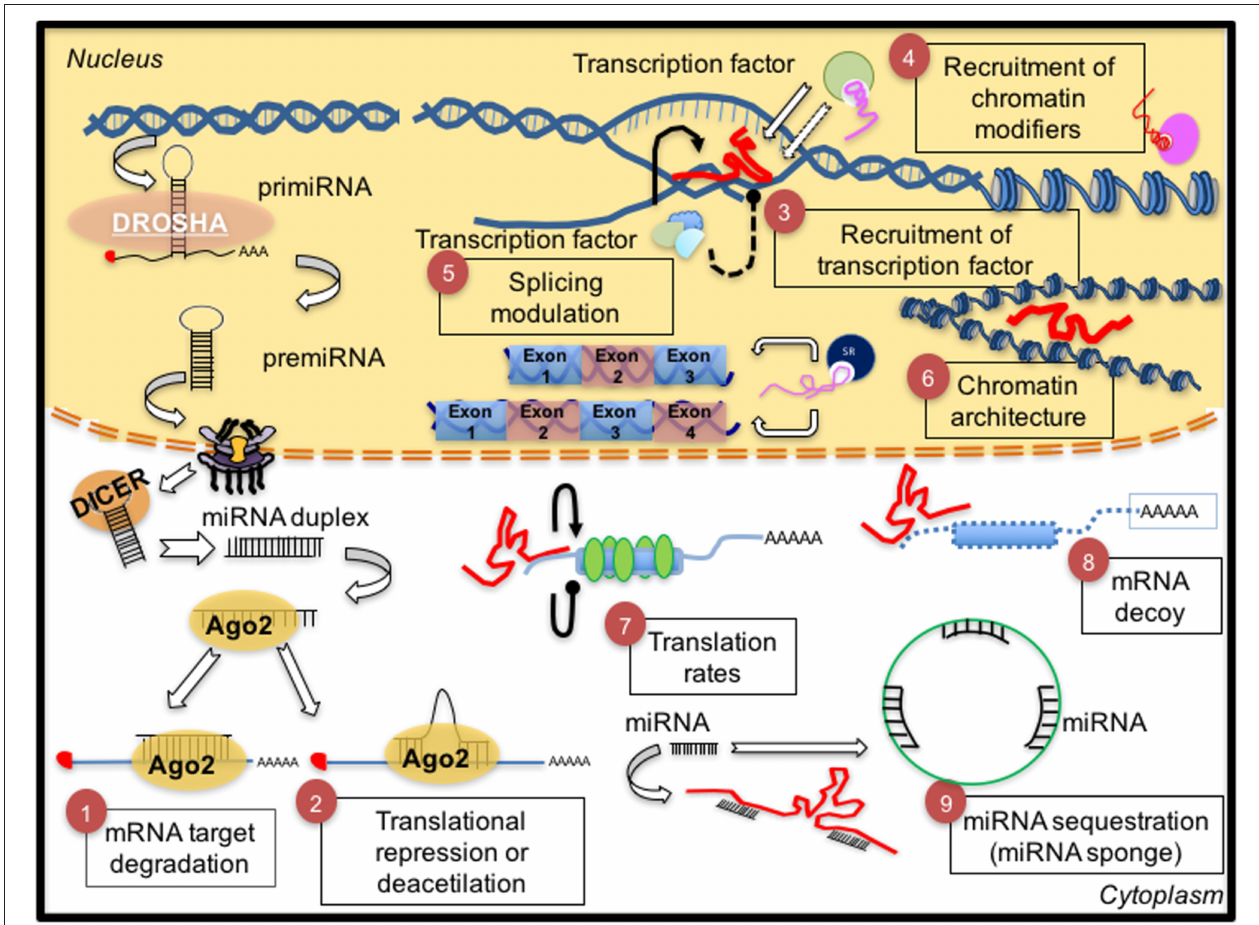
FIGURE 1 | Biological and mechanical overview of non-coding RNAs. (1, 2) Biogenesis of microRNAs and their main mechanisms of action. The pri-miRNA is transcribed by pol II polymerase and digested by the RNase DROSHA originating a pre-miRNA (70 nt), which is exported to the cytoplasm by exportin 5. Then, another RNase, Dicer, digests the pre-miRNA to generate a mature duplex miRNA ( ∼ 22 nt). One strand of this duplex is then incorporated in the miRISC complex (Ago2-microRNA) to target mRNA by perfect complementarity producing transcript degradation (1) or an imperfect one promoting translation repression (2). Conversely, (right side), general functions of lncRNAs are described. (3) Recruitment of transcription factors to promote transcription of target genes or (4) recruitment of chromatin modifiers and thus (6) promoting remodeling of the chromatin architecture. Other functions of lncRNAs are (5) control of alternative splicing of mRNA, and (7) control of translation rates favoring or inhibiting polysome loading to mRNAs, (8) acting as a decoy to preclude access of regulatory proteins to DNA. (9) The interaction between microRNAs and endogenous competent RNAs (ceRNAs) is a redundant system to regulate mRNA expression by lncRNAs-microRNAs; this mechanism is known as sponge function by lncRNAs. Thus, microRNA sequestration by lncRNA prevents microRNA functions on its